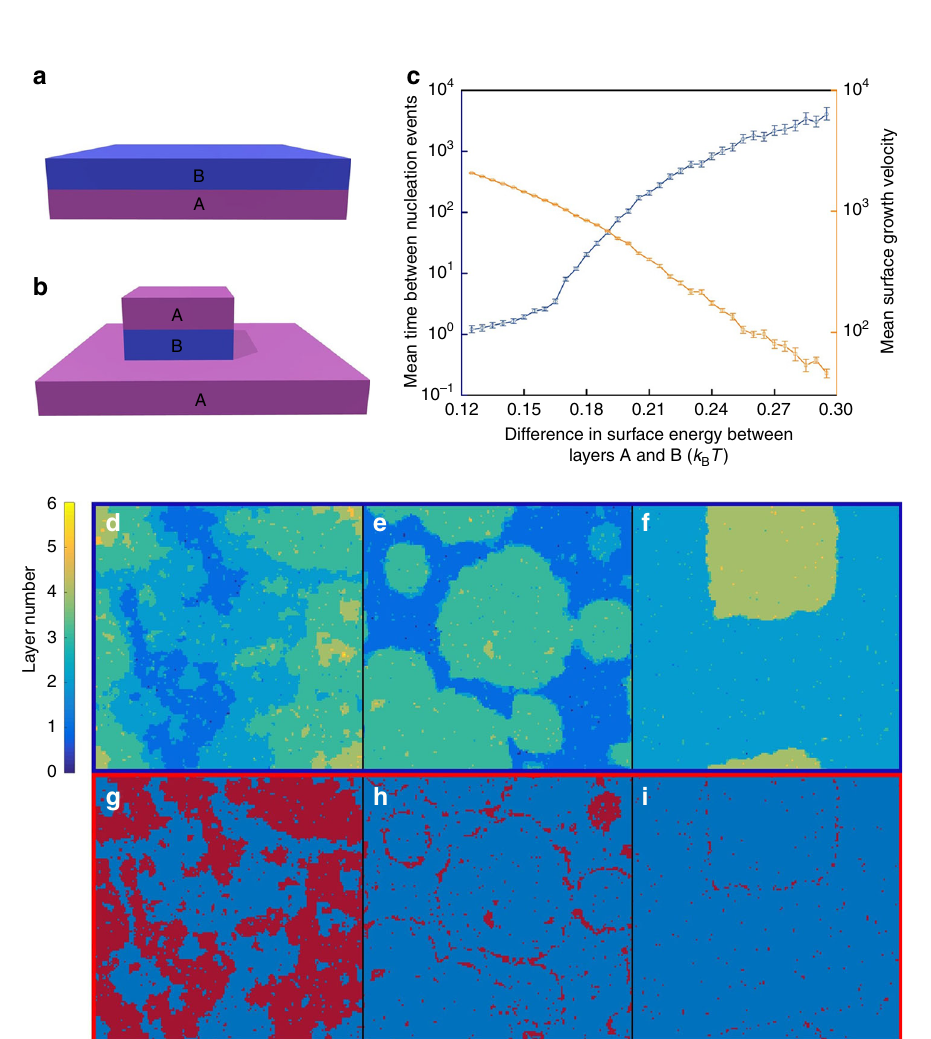
Fig. 5 Kinetics of epitaxial growth of alternating layers of A and B calculated using Monte-Carlo simulations ( γ edge = 0.65 k B T , Δ µ = − 0.3 k B T ). a , b Representative scheme of layer growth mechanisms in the presence of a minimal or no energy barrier ( a ) and a substantial energy barrier between A and B layers ( b ). c The mean time between nucleation events and the mean surface growth velocity plotted as a function of the energy barrier between layer growth. Error bars are from standard deviation and indicate 95% con fi dence interval. d – f Typical surface pro fi les for Δ γ A-B = 0 k B T , 0.12 k B T , and 0.29 k B T , respectively. g – i The same surface pro fi les colored with the low energy layer in blue and the high energy layer in red. The color scheme presented in g – i allows one to clearly view the placement of the high energy layer. As the energy barrier increases between layers, the presence of layer B is suppressed and is eventually only found near the terrace